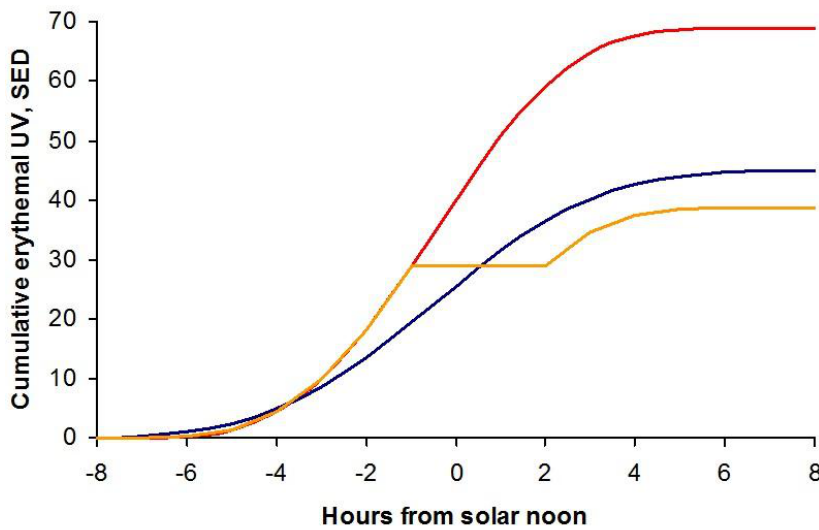
Figure 7. Cumulative ambient erythemal UV throughout a cloudless summer day in Tenerife (red curve) and Edinburgh (blue curve). Avoiding the sun for 3 h around the middle of the day in Tenerife is shown by the (orange curve).